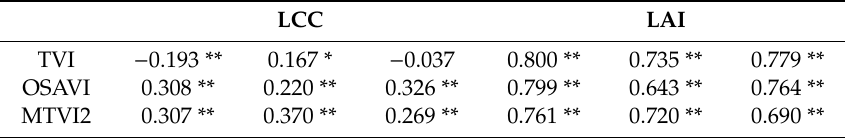
Table 6. Correlation coe ffi cients ( r ) between (i) TVI, OSAVI, MTVI2 and (ii) LCC, LAI for the 2002, 2010, and 2002 + 2010 datasets. LCC